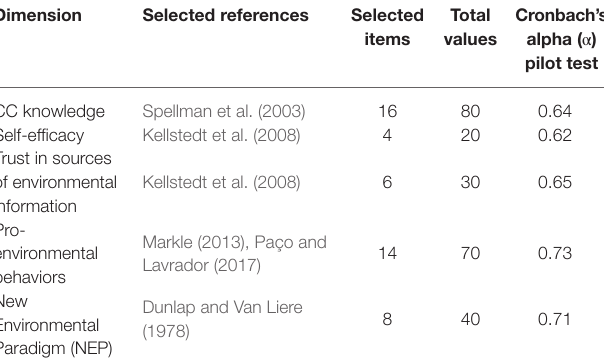
TABLE 2 | Dimensions of the survey.